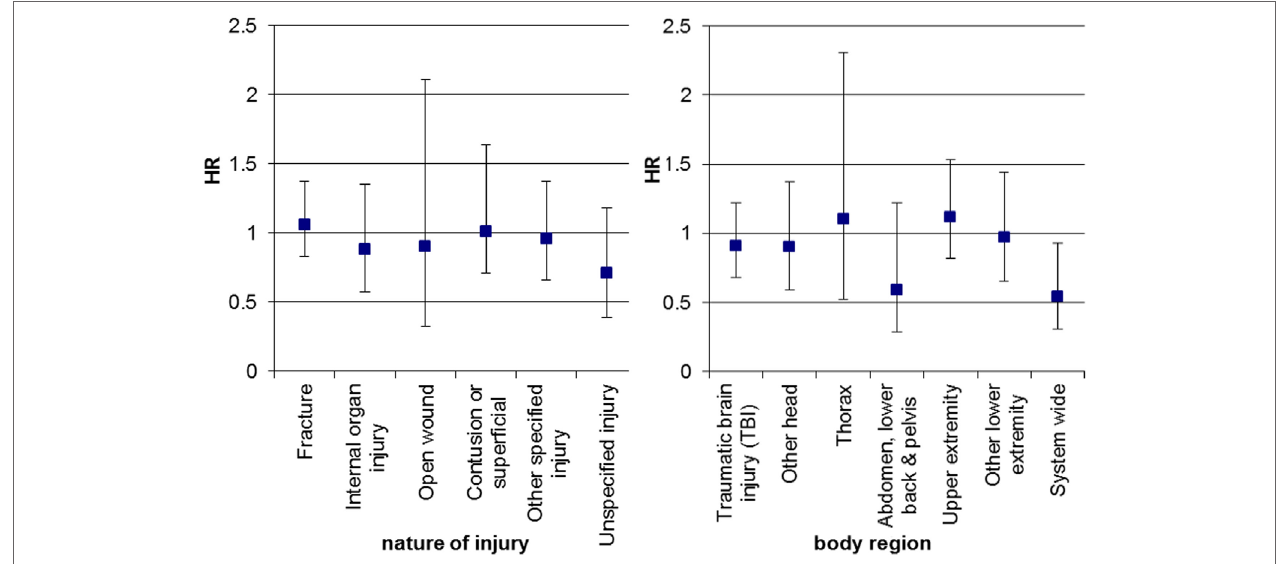
FigUre 3 | Sex-related difference on the influence of ADHD on hospitalization with injuries for boys versus girls*. Cox regression analysis, HR, hazard ratio for the interaction of sex and ADHD status for boys versus girls adjusted for age at hospitalization and the main effects of sex and ADHD case status, whiskers indicate 95% confidence intervals. *Only injury categories with at least 150 events were